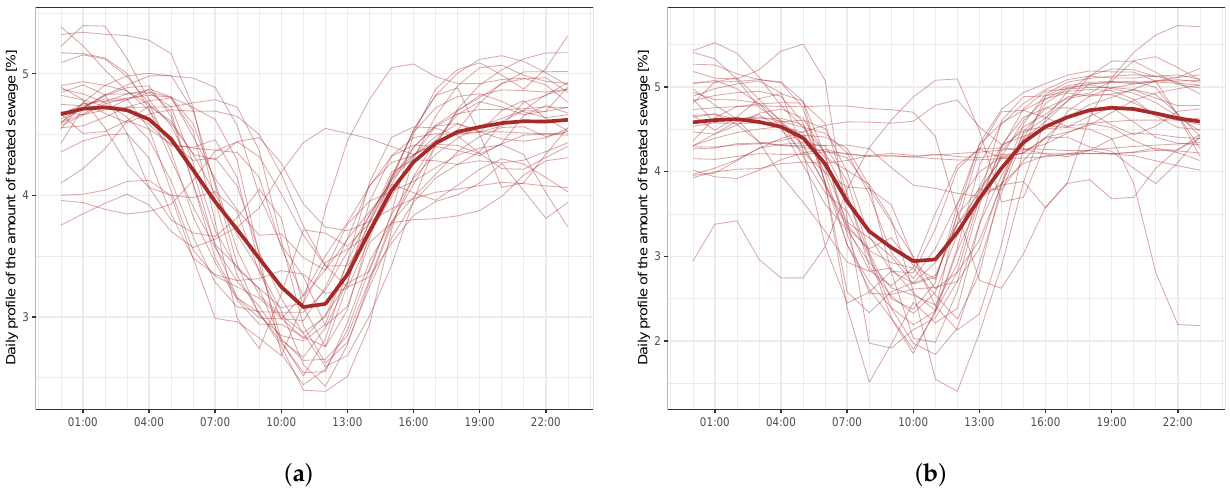
Figure 7. Profile of the daily volume of treated wastewater. ( a ) February 2022; ( b ) September